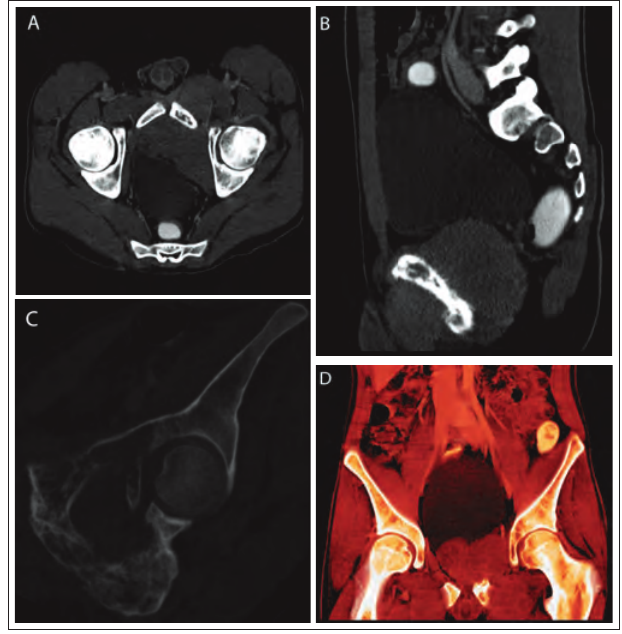
Fig. 6. Sequence of CT images illustrate the extent of the large heterogeneously enhanced soft-tissue tumour that infiltrates the obturator internis muscle and proximal adductor compartment and invades the pelvic floor on the left, also elevated and infiltrating the bladder base. (a) Axial post contrast cut through the pelvis. (b) Sagittal post contrast CT. (c) Oblique coronal CT (bony window depicts the aggressive permeated infiltration and associated periosteal reaction). (d)Volumetric oblique coronal CT.